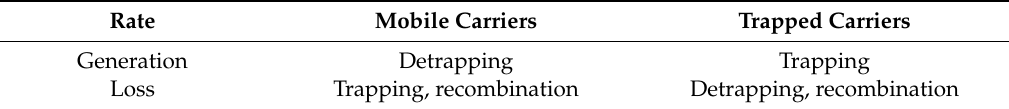
Table 2. Mechanism of generation and losses of charge